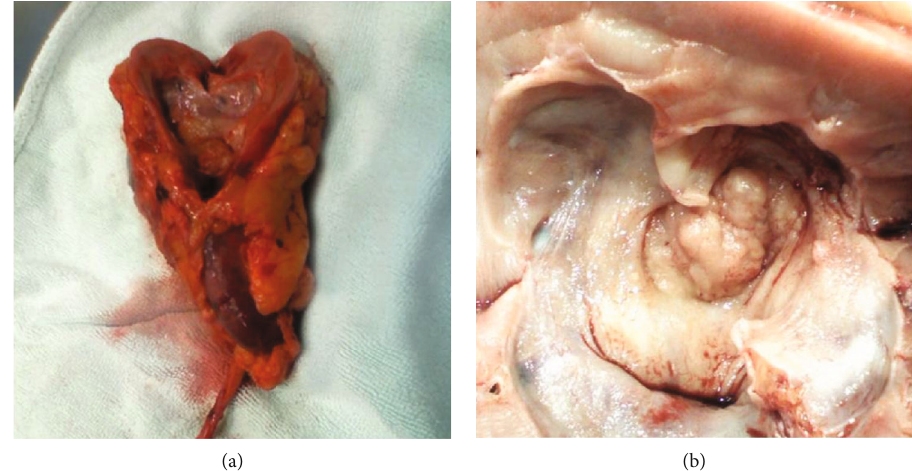
Figure 2: Gross appearance of the left kidney and ureter showing the in fi ltration of the perihilar fat (a) by a vegetative tumor of the renal pelvis measuring 3 × 2 : 5 cm and invading the adjacent renal parenchyma